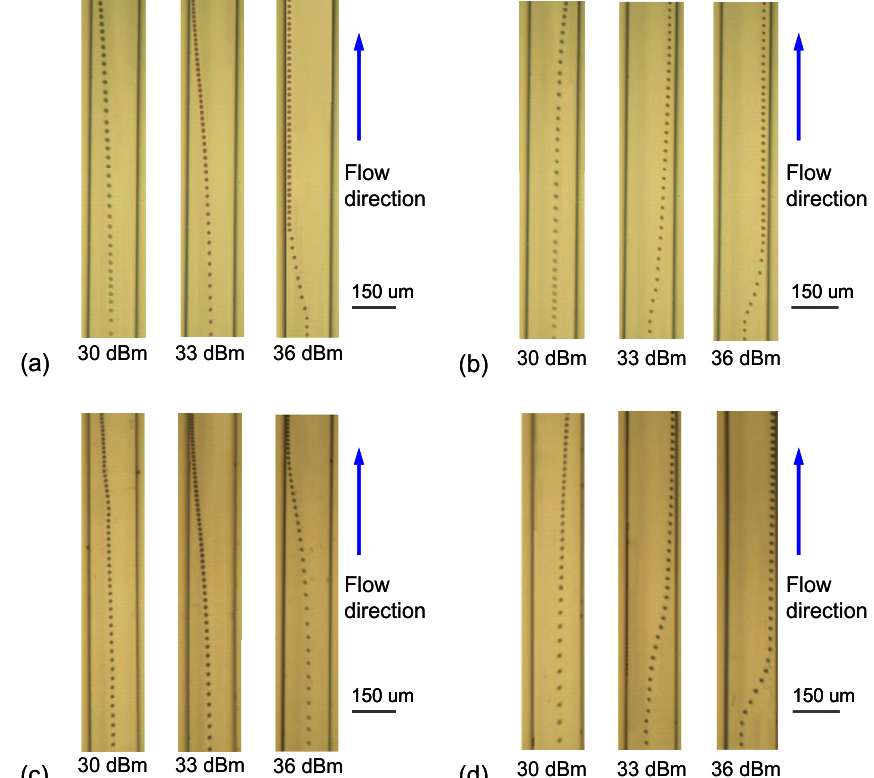
Figure 10. Experimental trajectories of the lateral displacement of a particle along the microfluidic channel with input RF power levels corresponding to 30 dBm, 33 dBm and 36 dBm in the design of parallel IDTs with input frequency ( a ) f P 1 and ( b ) f P 2 ; and in the design of series IDTs with input frequency ( c ) f S 1 and ( d ) f S 2 .